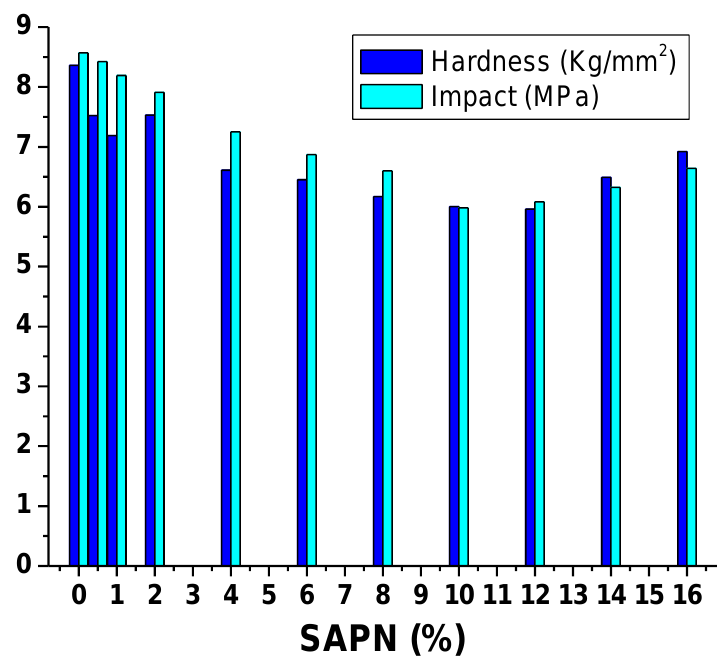
Figure 10. Mechanical efficiency of SAPN@PCP.